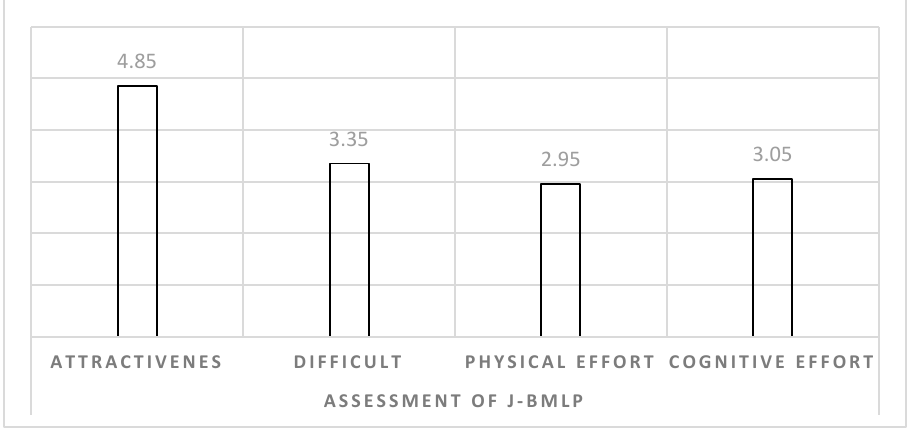
Figure 4. Participants’ assessment of J-BMLP.